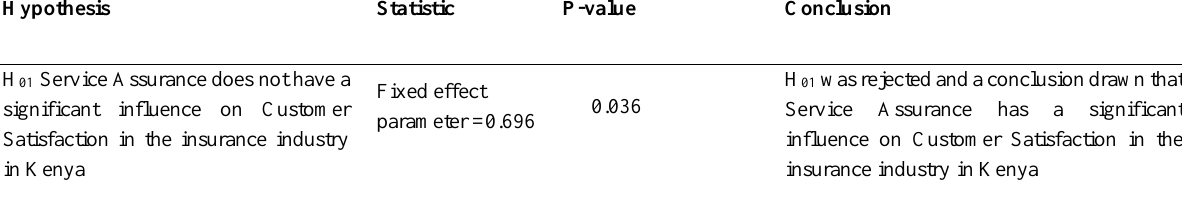
Table 7: Hypothesis